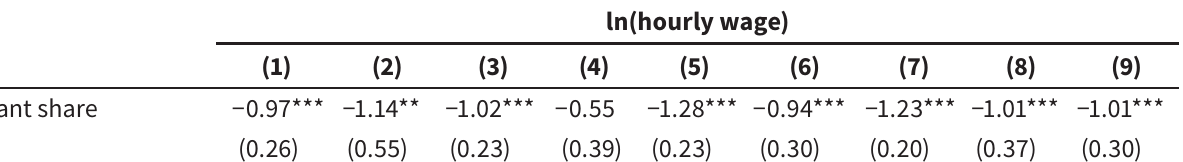
2SLS wage effects interacted with regional